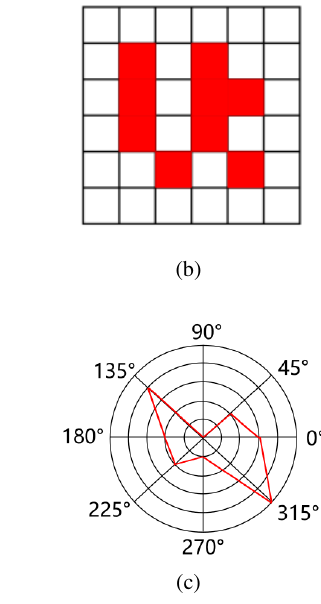
Figure 8. ( a ) Demonstrates how GDDN enables motion detection of a U-shaped object moving Figure 8. (a). Demonstrates how GDDN enables motion detection of a U-shaped object moving down-rightward down-rightward in a 6 × 6 grayscale background. The two images (left) represent the position of the in a 6 6 grayscale background. The two images left represent the position of the object at time t and time t + × object at time t and time t + ∆ t , respectively, and the red areas in the eight images (right) represent ∆ t respectively, and the red areas in the eight images right represent the location and number of activated LDDN. the location and number of activated LDDN. ( b ) The red areas in this diagram represent the locations (b). The red areas in this diagram represent the locations where LDDN has been activated in this receptive field. where LDDN has been activated in this receptive field; ( c ) radar plot of the GDDN detection results, (c). Radar plot of the GDDN detection results, from which it can be seen that the LDDN corresponding to the from which it can be seen that the LDDN corresponding to the down-rightward was activated down-rightward was activated most frequently. most